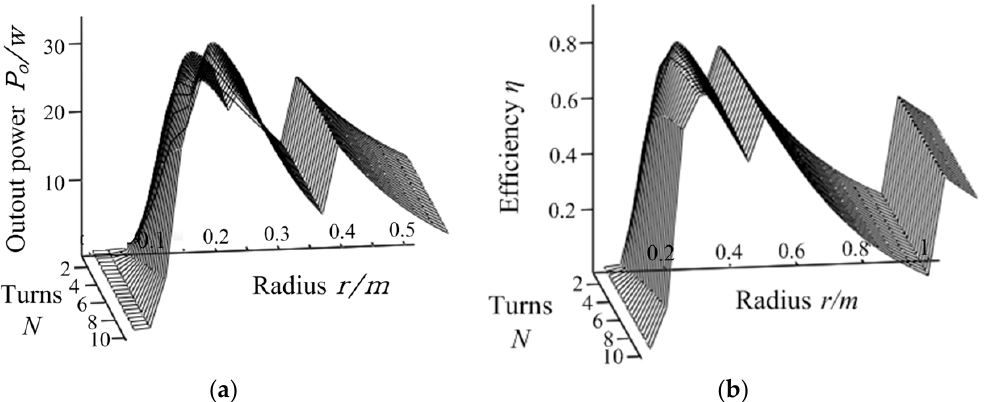
Figure 7. Output power P 0 (a) and the efficiency η (b) with respect to the turns N and radius r.